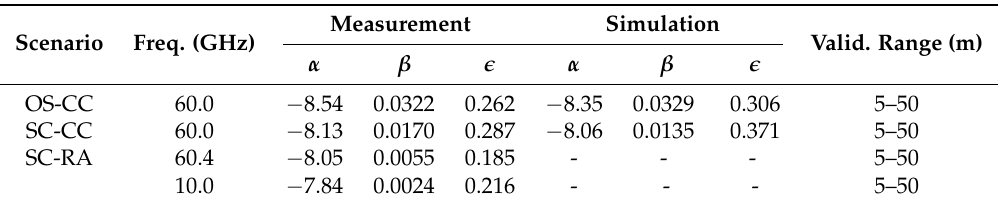
Table 4. Parameters for distance-dependent DS model for line-of-sight (LOS): intercept point α , slope β and standard deviation (cid:101) .